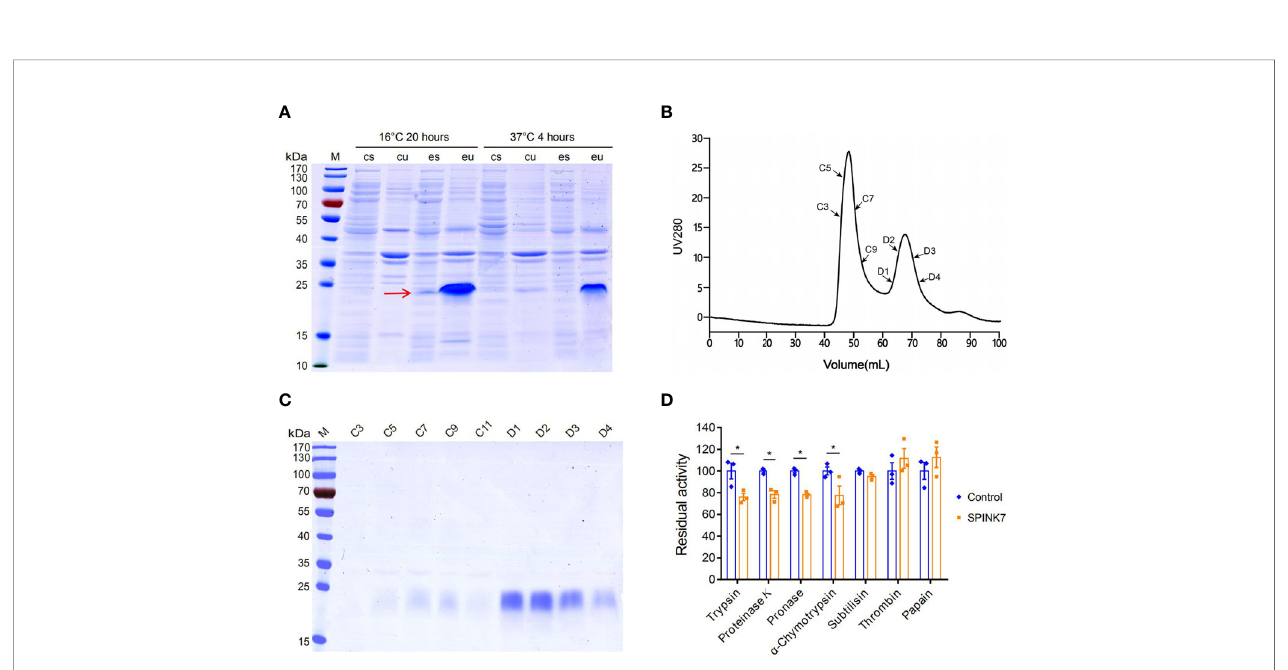
FIGURE 2 | SPINK7 prokaryotic expression and activity. (A) SDS-PAGE analyses of recombinant SPINK7 protein. E. coli BL21 were induced with 0.1 mM IPTG at 16°C for 20 h or at 37°C for 4 h. Uninduced E. coli BL21 were used as the control. “ M ” indicates the molecular weight standards. “ cu ” and “ eu ” represent the insoluble component in the control and experimental samples, respectively. “ cs ” and “ es ” represent the supernatant proteins in the control and experiment samples, respectively. The arrow shows soluble SPINK7 protein. (B) Puri fi cation of the recombinant SPINK7 by gel fi ltration after af fi nity column chromatography. (C) SDS- PAGE analyses of SPINK7 after gel fi ltration. “ C ” and “ D ” represent the third and fourth elution peak, respectively. “ C1-11 ” represents the fi rst to eleventh tubes of protein solution collected from the third peak, whereas “ D1-4 ” represents the fi rst to fourth tubes of protein solution collected from the fourth peak. (D) Detection of recombinant SPINK7 inhibitory activities against various proteases. Bars on graph indicate standard error of the mean (n = 3). Student ’ s t-test: *P < 0.05.